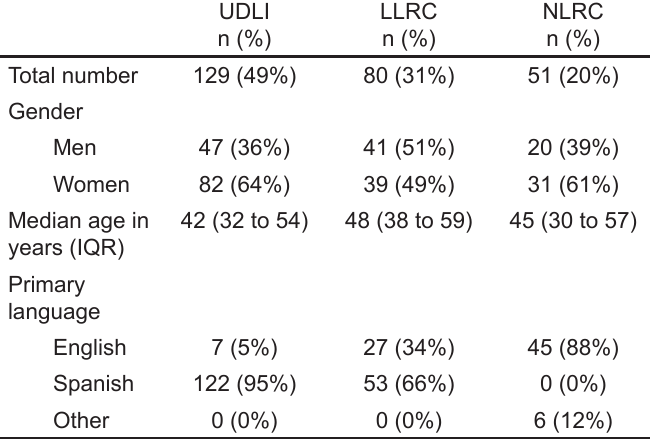
Figure. Process of excluding and consolidating open-ended pa- tient commentary for multi-site emergency department